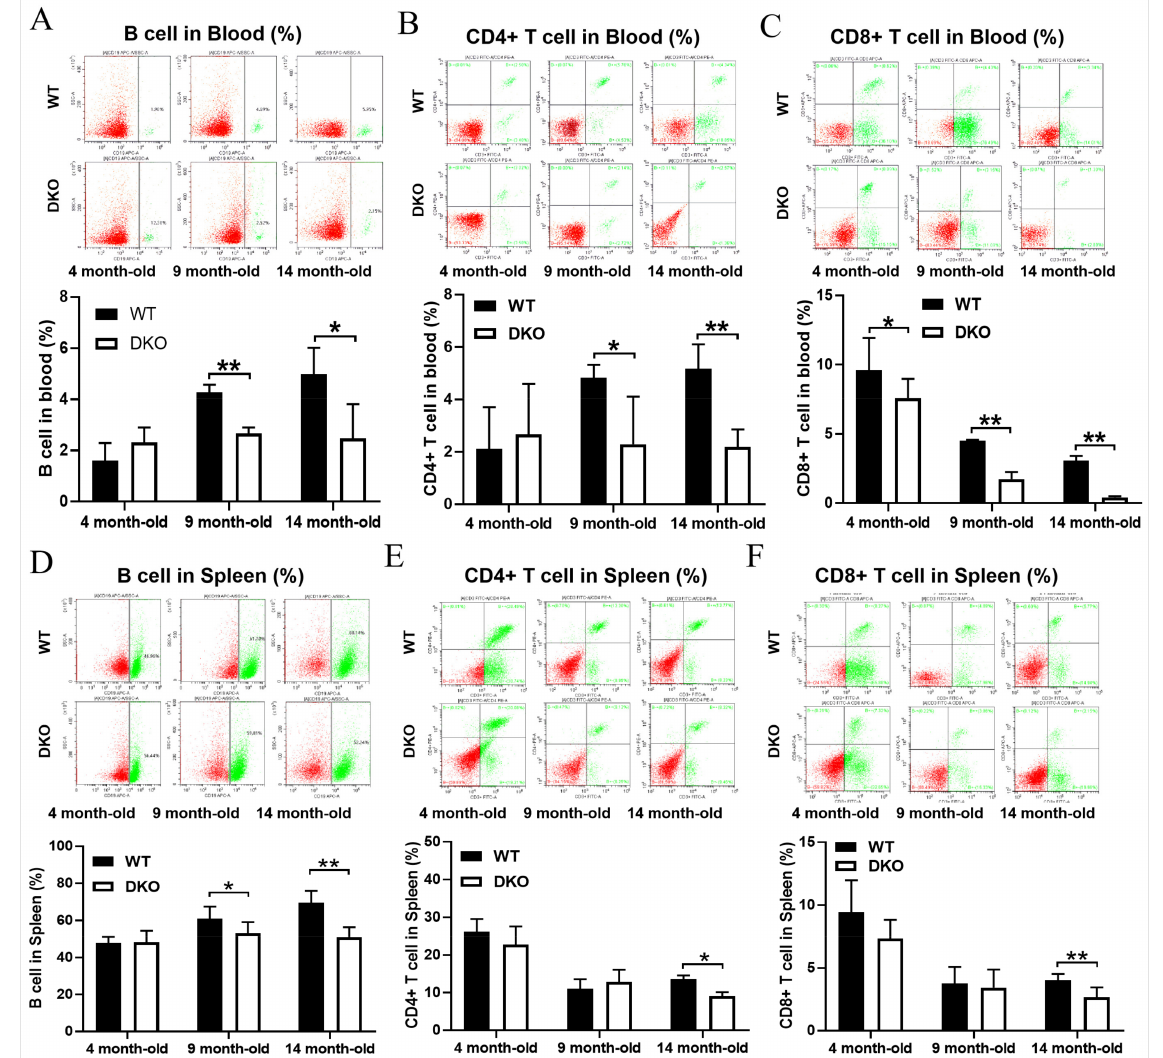
Figure 2. B, CD3+-CD4+T, and CD3+-CD8+T cells in the blood ( A – C ) and spleen ( D – F ) of DKO and WT mice at different months of age. Data are presented as mean ± SD, n = 6. * p < 0.05, ** p <